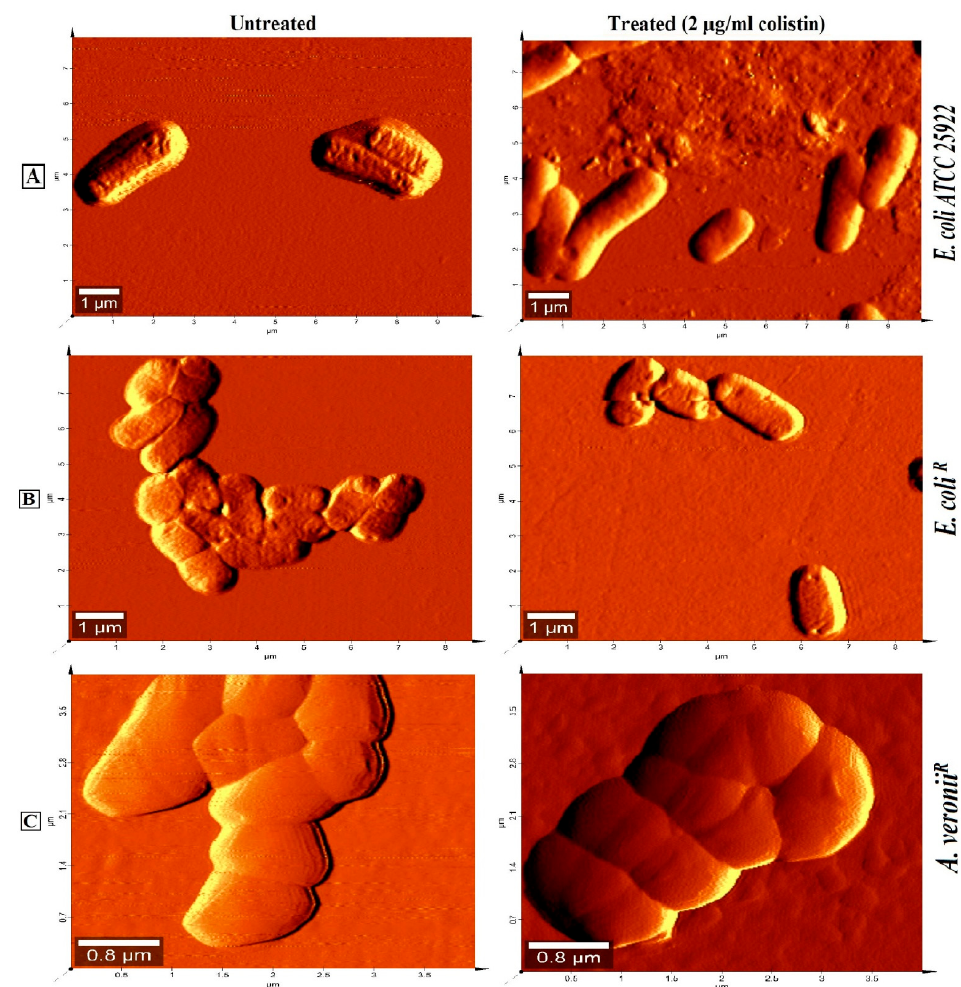
Figure 4. Atomic force microscopy images in dimensions (µm) of mid-logarithmic phase colistin susceptible and resistant cells treated with 2 µg/mL colistin for 20 min ( A ); E. coli ATCC 25922 ( B ); E. coli ; ( C ) A. veronii R .